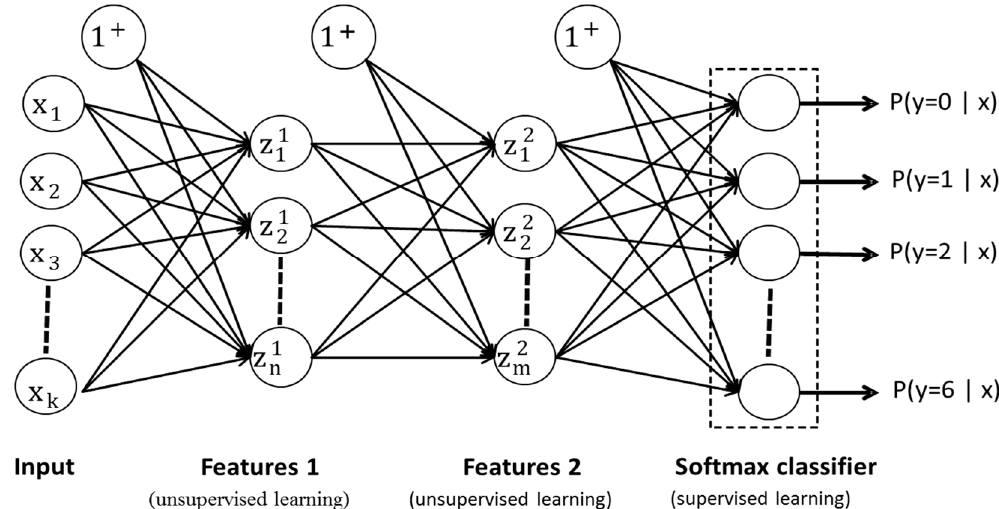
Figure 2. Block diagram of stacked sparse autoencoders (SSAE). The features are learned in an unsupervised way, while classification is performed in the supervised fashion. The lengths of both layers were adjusted accordingly to input the lengths of SSAE-f (k = 4 × 8, n = 32, m = 6) and SSAE-r (k = 30 × 8, n = 100, m = 50).